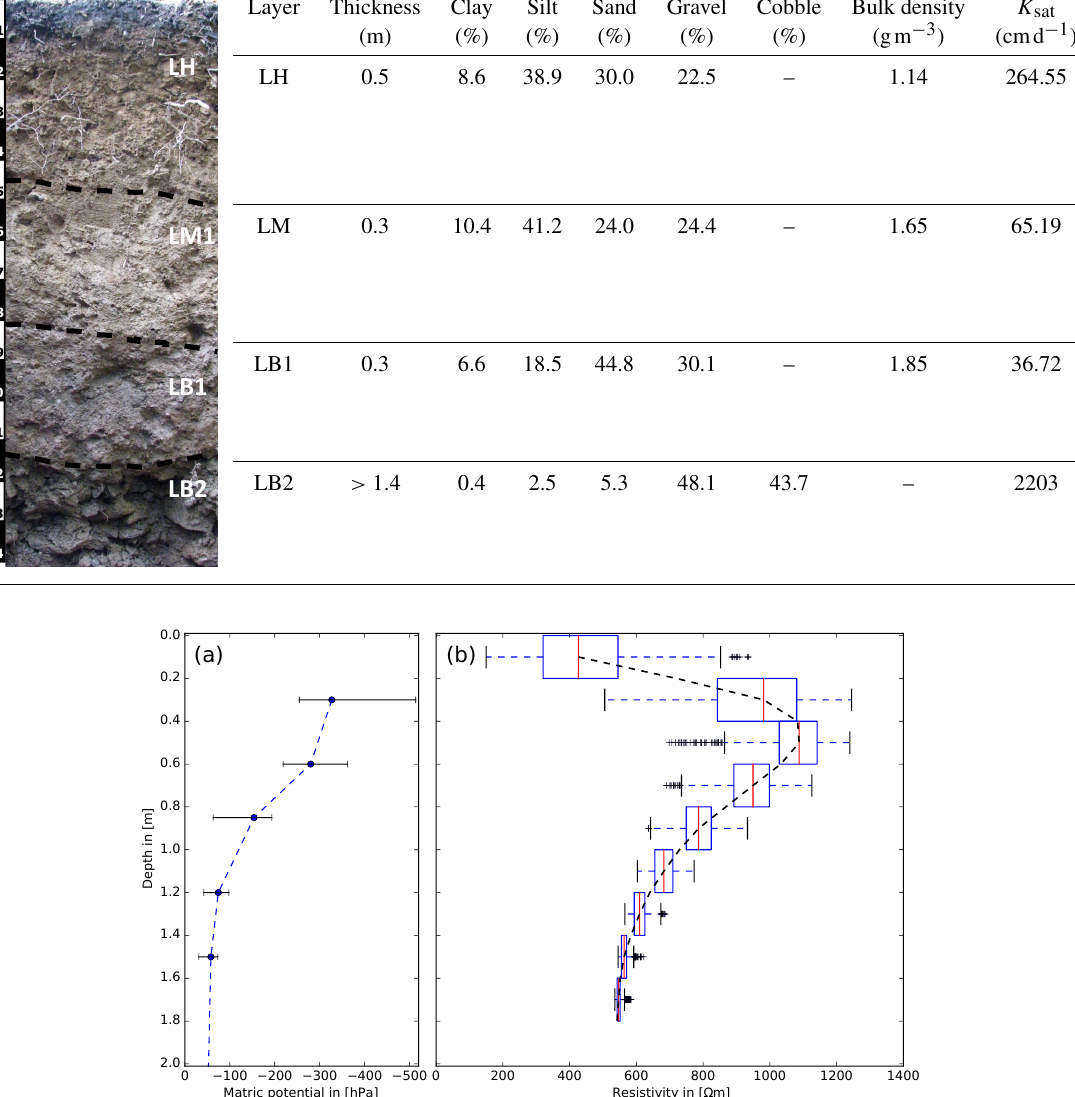
Table 1. Sedimentological properties (grain size distribution, bulk density and saturated hydraulic conductivity K sat ) of the subsurface layers.